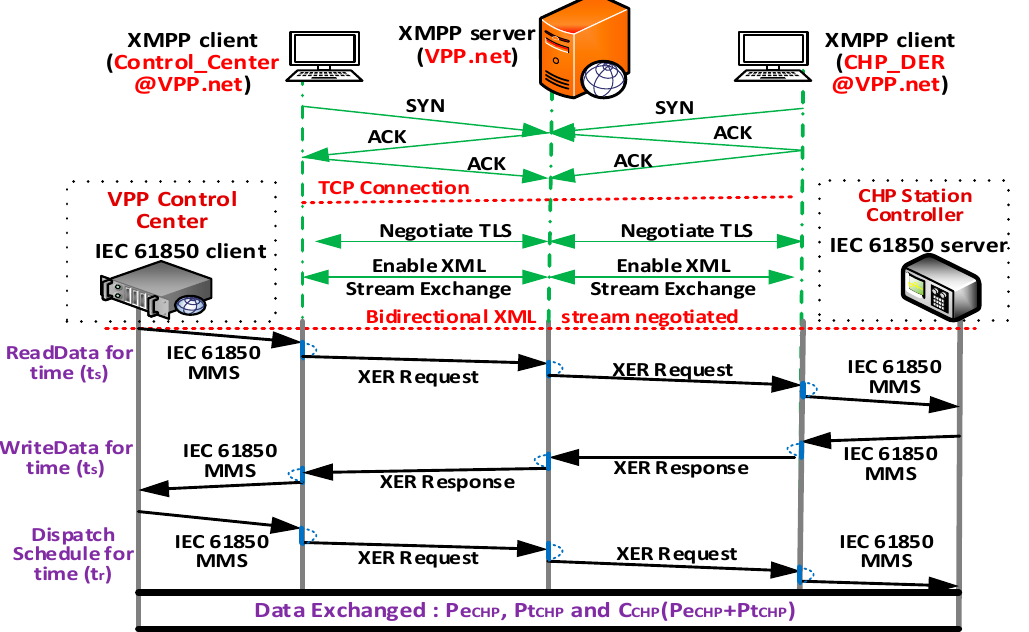
Figure 4. Message Flow for EM between VPP and Combined Heat and Power (CHP) in a single JabberID